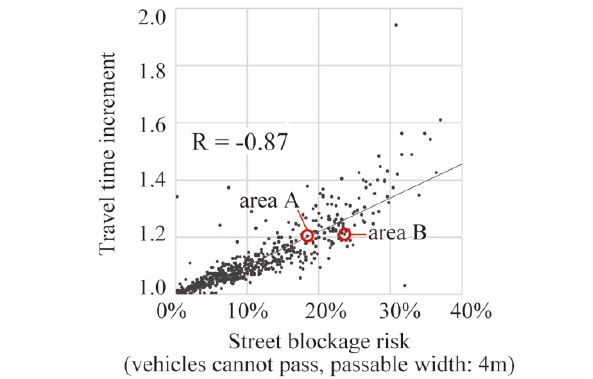
Figure 13. Comparison of street blockage risk and TTI